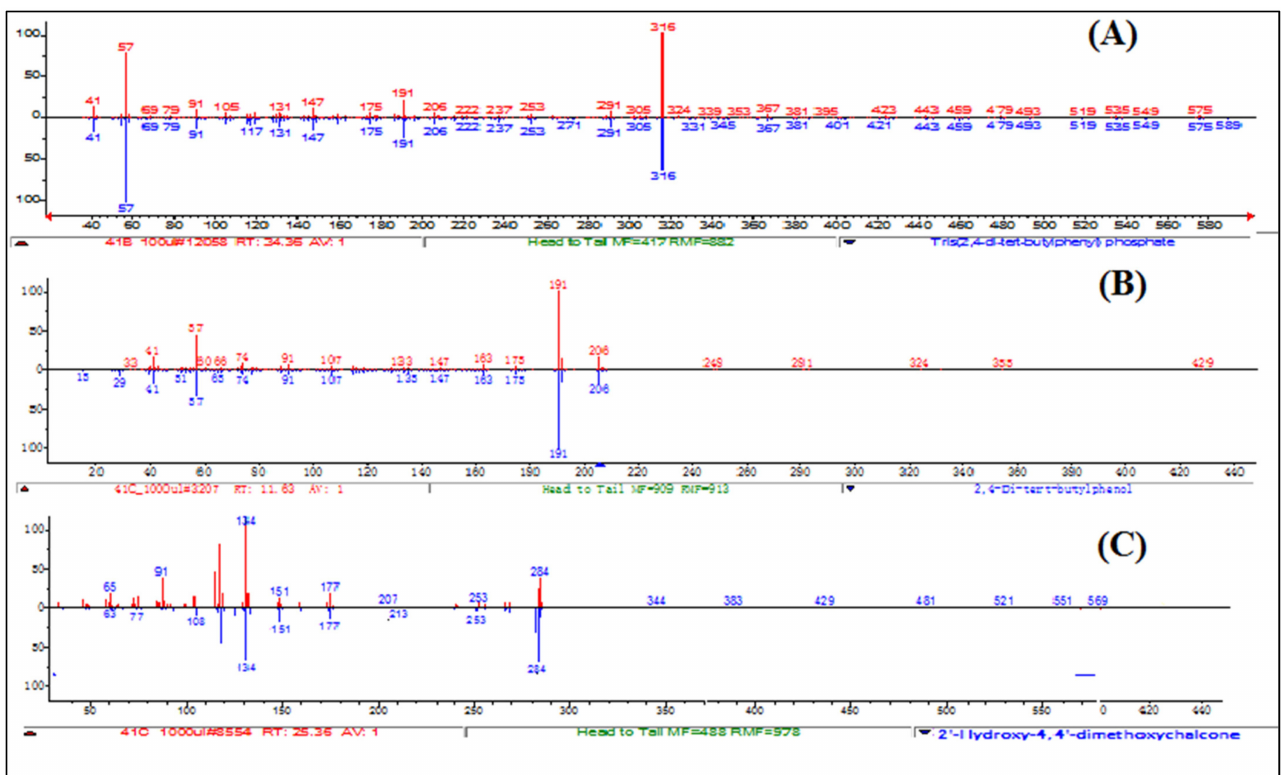
Figure 10. Mass spectra of Compound ( A ) Tris (2,4-di- tert -butylphenyl), ( B ) (2,4-di- tert -butylphenol), and ( C ) (4-Hydroxy-2,4 (cid:48) -dimethoxychalcone). Compound 3 is a yellow powder identified to be 2,4-di- tert -butylphenol (Figures 8–10) with molecular formula C 14 H 22 O. This compound is a member of the class of phenols with two tert -butyl substituents at positions 2 and 4. This compound is previously been reported from variety of plants i.e., from chloroform and methanol extracts of Cuscuta reflexa [44], methanolic extract of Cordia dicodoma , Malvastrum coromandelianum (L.) Garcke leaves [45]. However, there is no report of this compound “Tris (2,4-di- tert -butylphenyl) phosphate” from Asteraceae